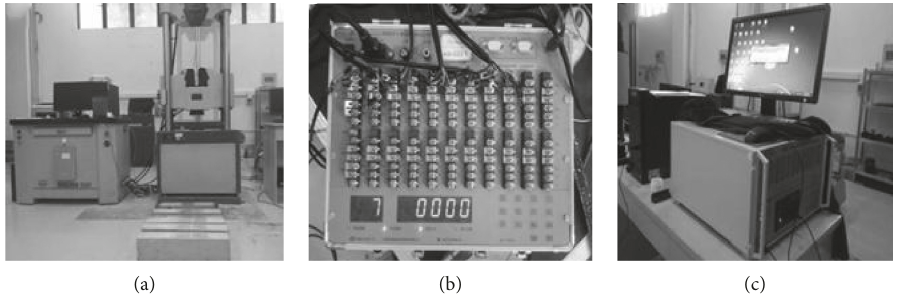
Figure 3: Stress-strain acquisition equipment and PCI-2 type acoustic emission system. (a) WAW-1000 kN microcomputer controlled electro-hydraulic servo universal testing machine; (b) DH3818 static strain data acquisition instrument; (c) the PCI-2 type acoustic emission system.